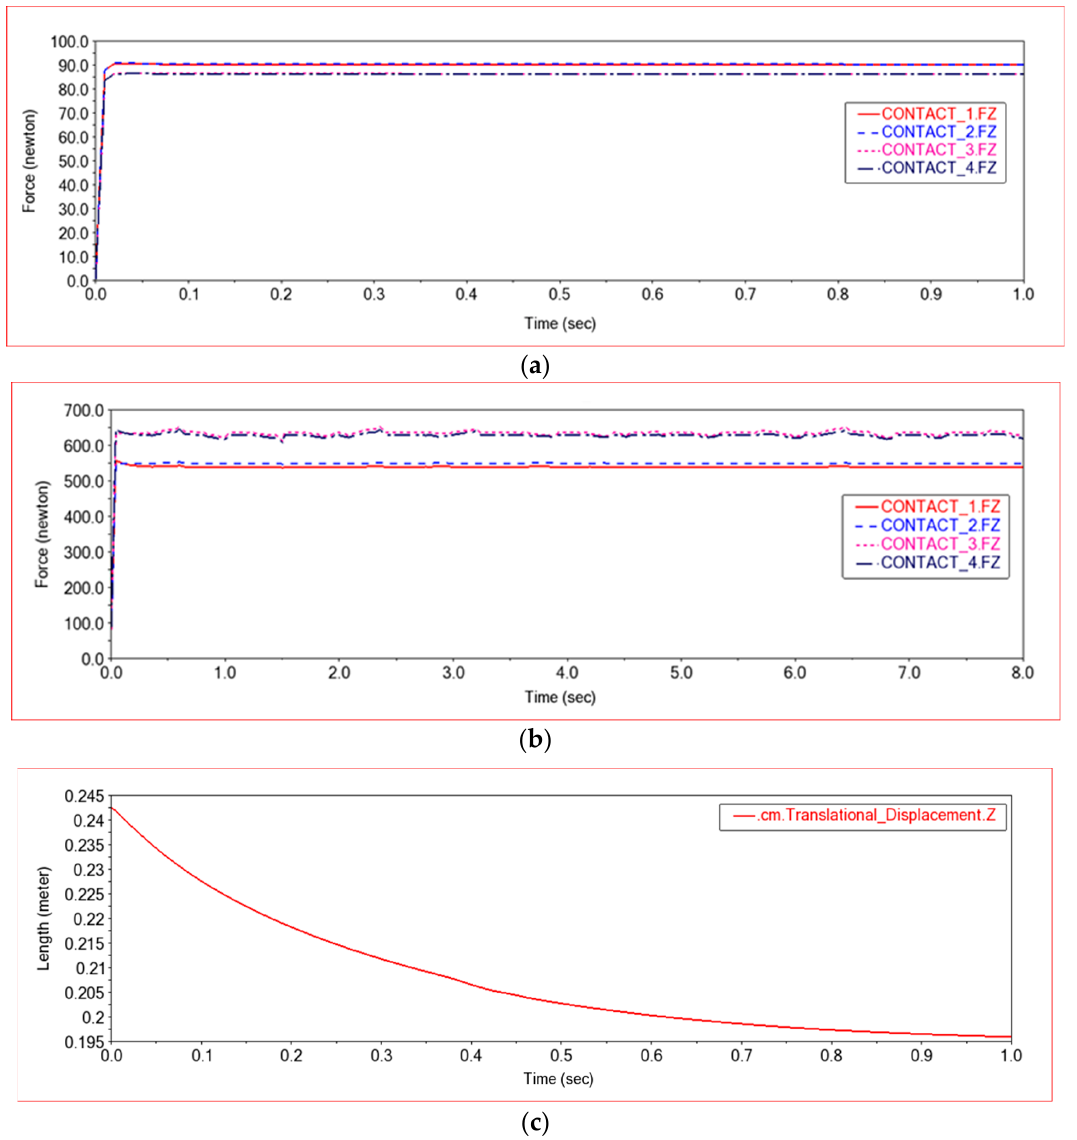
Figure 5. Vehicle load test experiment. ( a ) Supporting force curve before loading, ( b ) Supporting force curve after loading, ( c ) Centroid displacement curve. CONTACT_1—Left front wheel and ground contact force; CONTACT_2—Right front wheel and ground contact force; CONTACT_3—Left rear wheel and ground contact force; CONTACT_4—Right rear wheel and ground contact force.